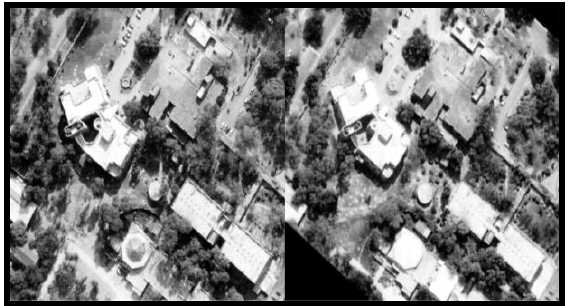
Figure 5. Aerial Image (left) and Google Earth Image (right)